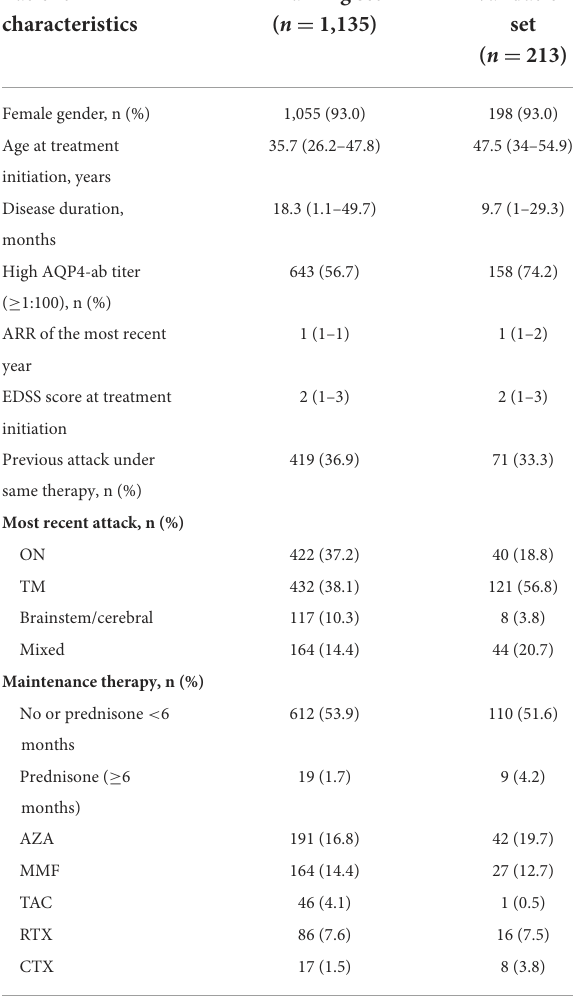
TABLE 1 The demographic and clinical characteristics of AQP4-ab positive NMOSD patients in the training and validation